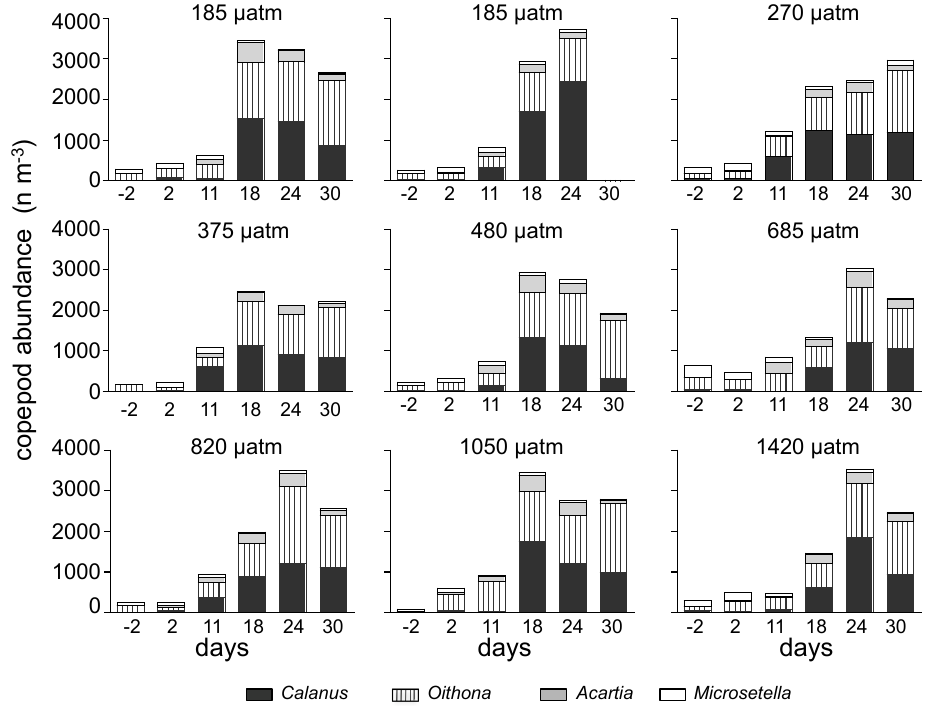
Fig. 8. Copepod abundance and taxonomic composition (genera) in the water column of the mesocosms; the data presented here include copepodites and adults of the respective genus; numbers on top of the panels present the initial CO 2 concentration in each mesocosm after the CO 2 manipulation was completed. At t 30 , no samples were taken in M7 (185µatm) and no data are